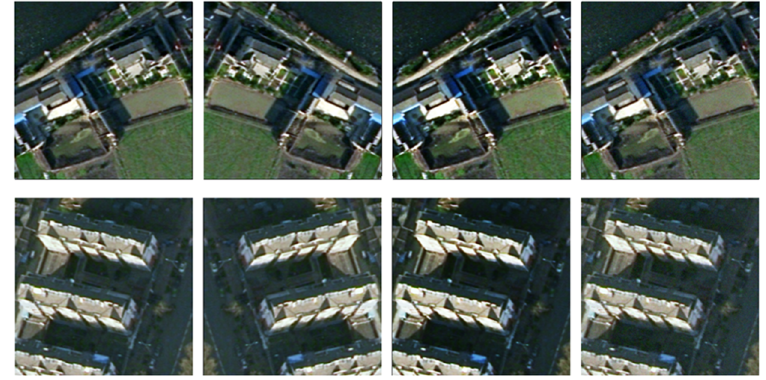
Figure 7. Data augmentation examples.